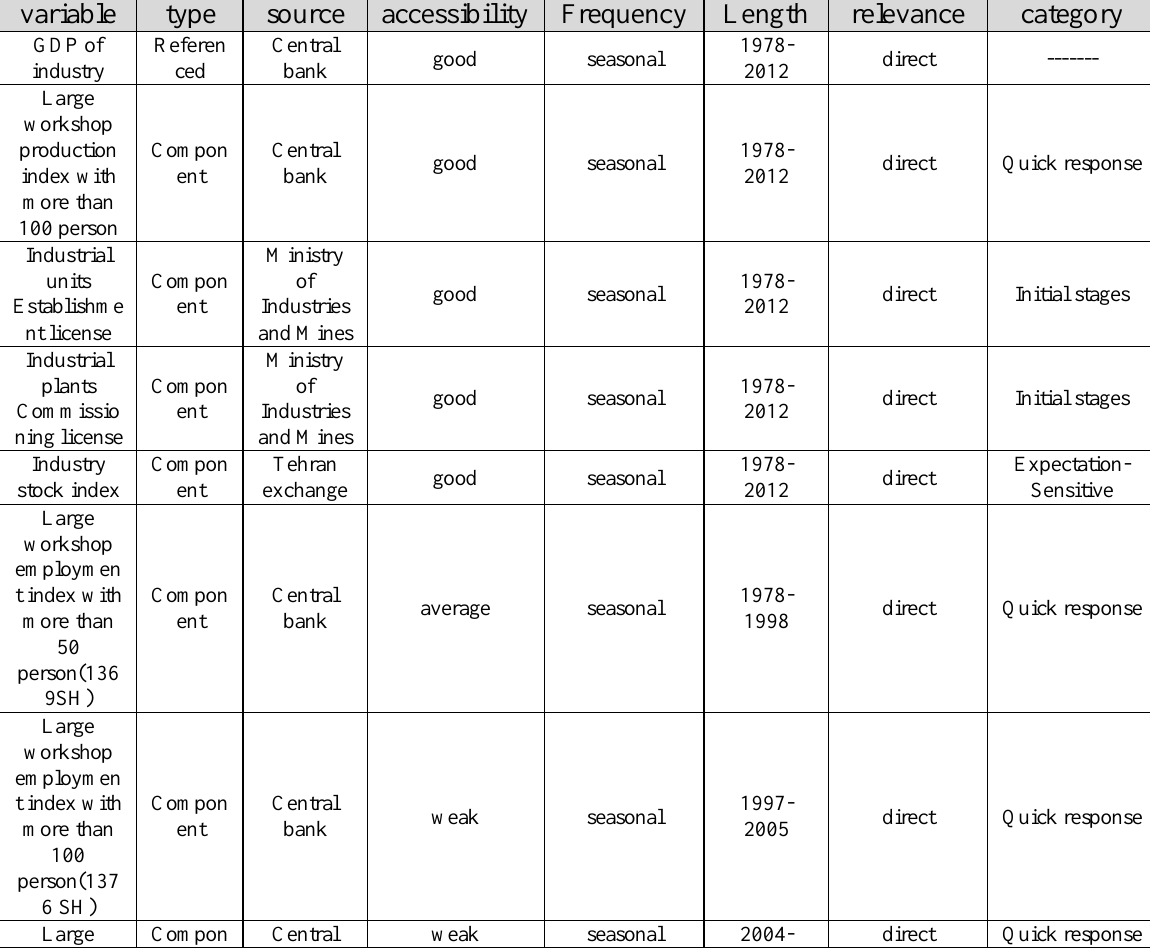
Table 1. List of potential reference variables and components